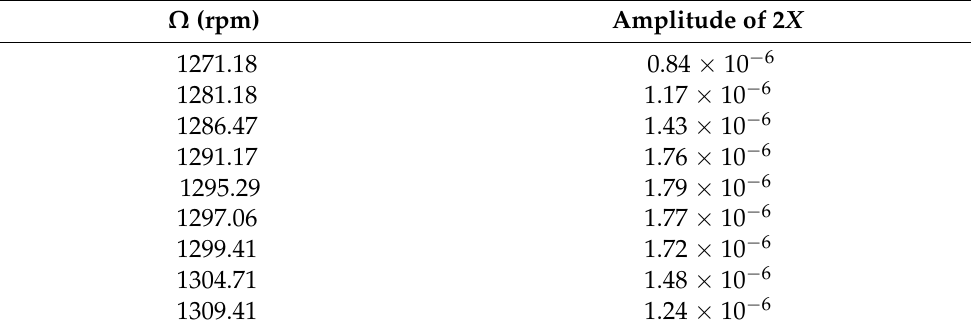
for α = 0.01 in [45]. 2